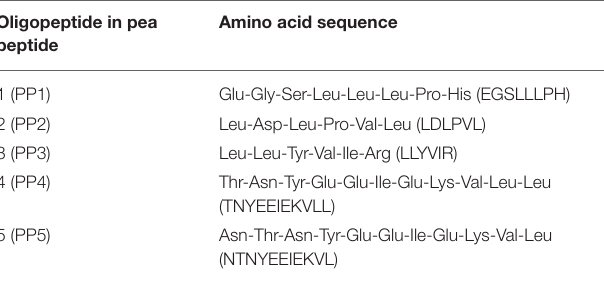
TABLE 2 | Amino acid sequence of oligopeptide in pea peptide. Oligopeptide in pea